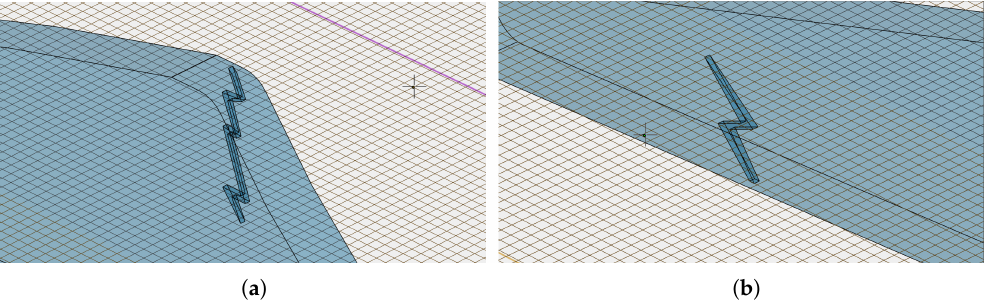
Figure 19. Narrow zigzag cracks that are not visible: ( a ) first crack; ( b ) second crack. In addition, we will rotate the simple blade 90 ◦ in a clockwise direction, as seen in Figure 20.